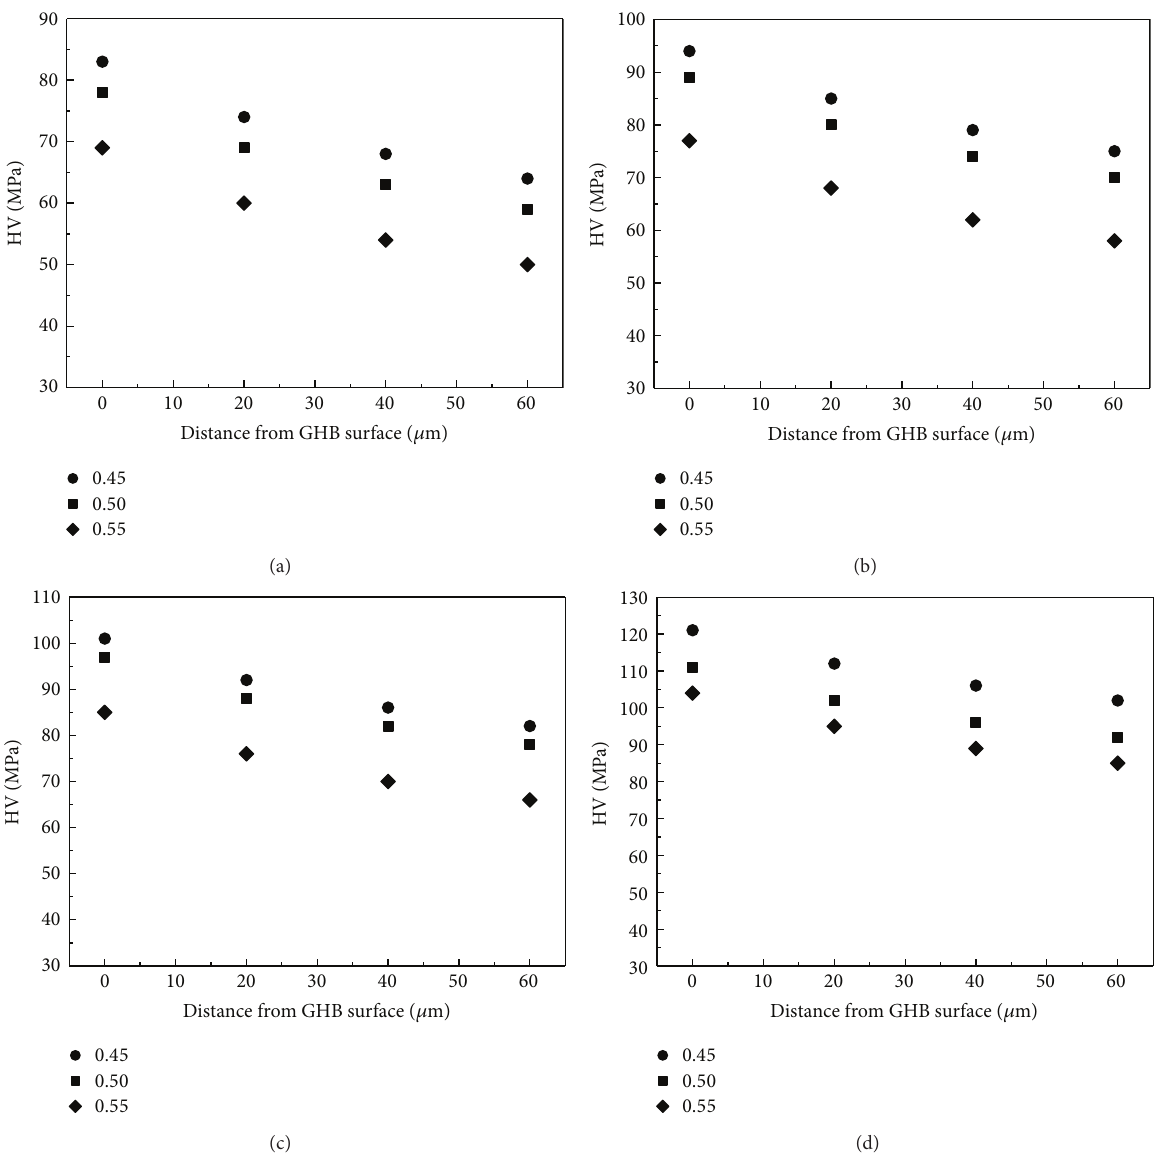
Figure 11: The influence of water to cement ratio on the interfacial HV of cement paste ((a) for 7 d, (b) for 14 d, (c) for 28 d, and (d) for 56 d). forms a layer of water film of few microns in the mixing process, and the NS with super large specific surface